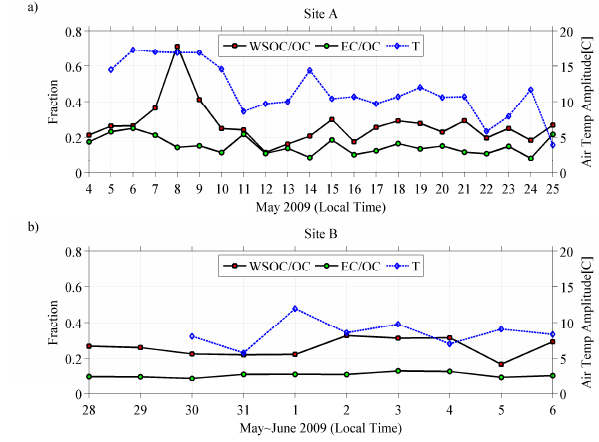
Figure 11 : Daily ratio of water soluble organic carbon (WSOC/OC) and elemental carbon to organic carbon (EC/OC) and the diurnal temperature amplitude (maximum daily temperature-minimum daily temperature) for Site A (a) and Site B (b). The EC/OC ratio was lower in Site B compared to Site A.